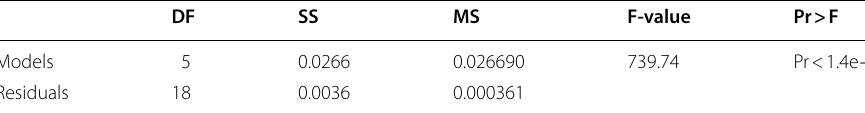
Table 12 ANOVA PCA statistics